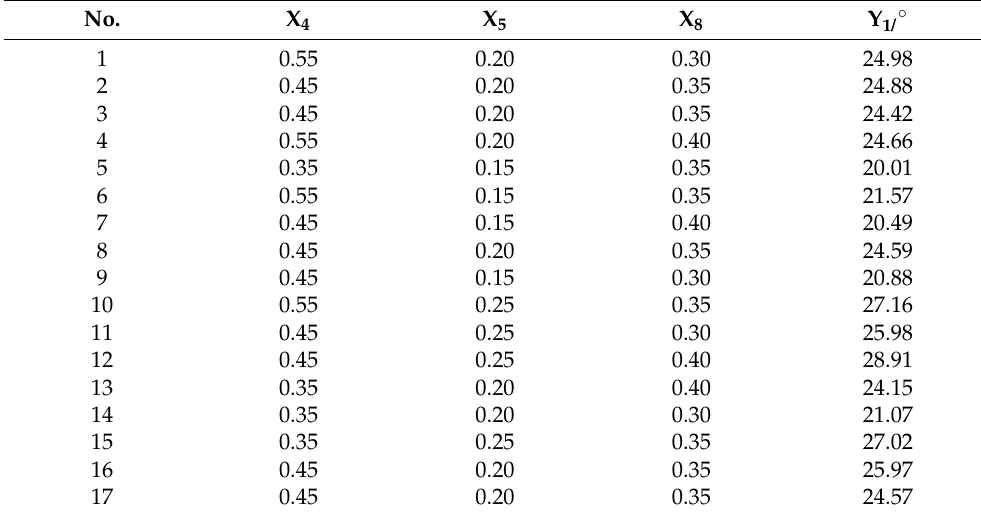
Table 7. The stacking angle response surface test and results.